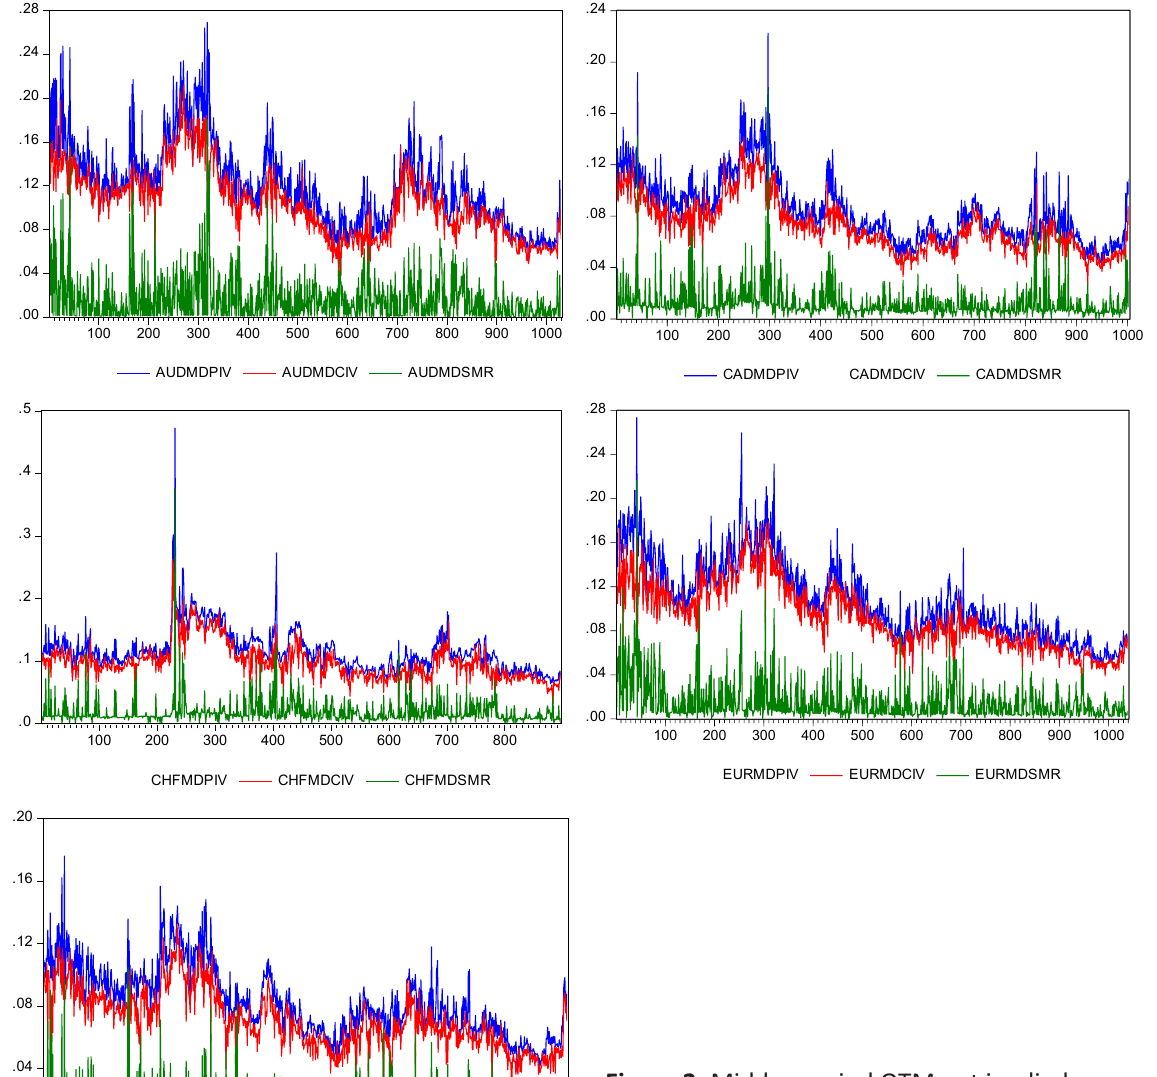
Figure 2. Midday period OTM put implied volatility (blue color), ATM call implied volatility (red color) and volatility smirk (green color)